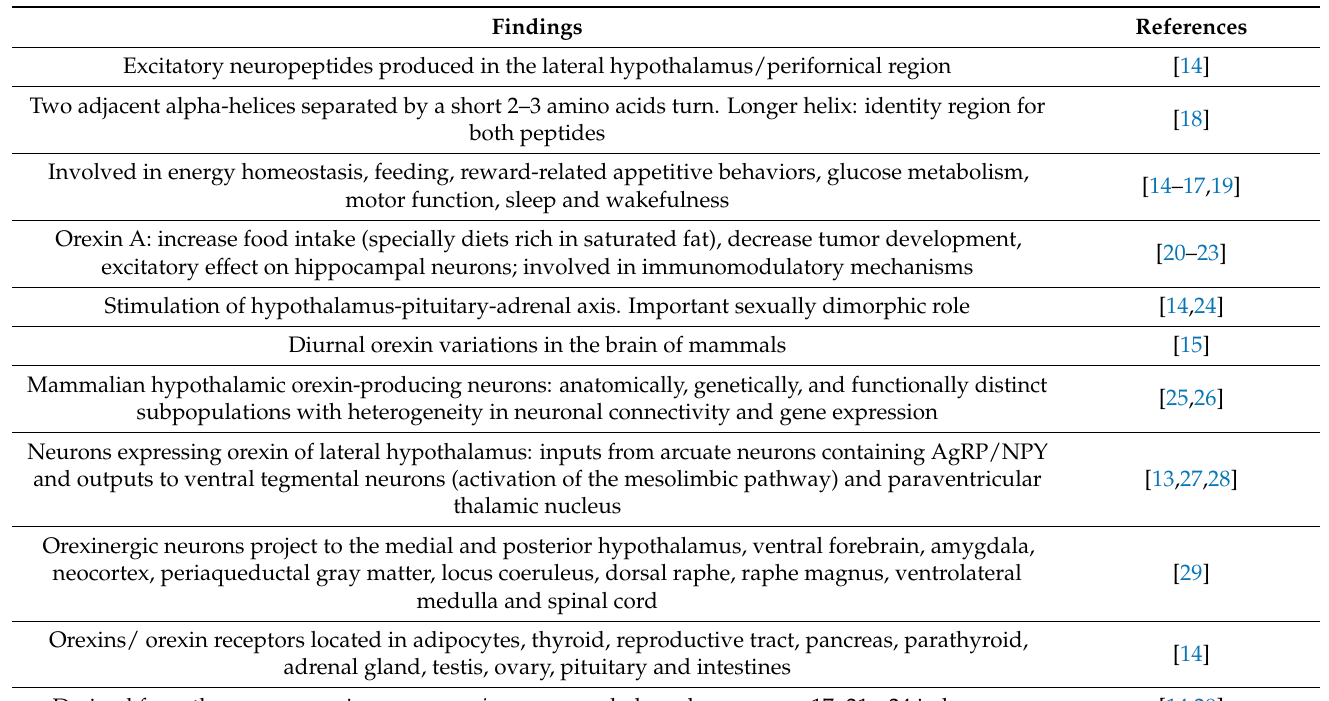
Table 1. Orexins: general characteristics.